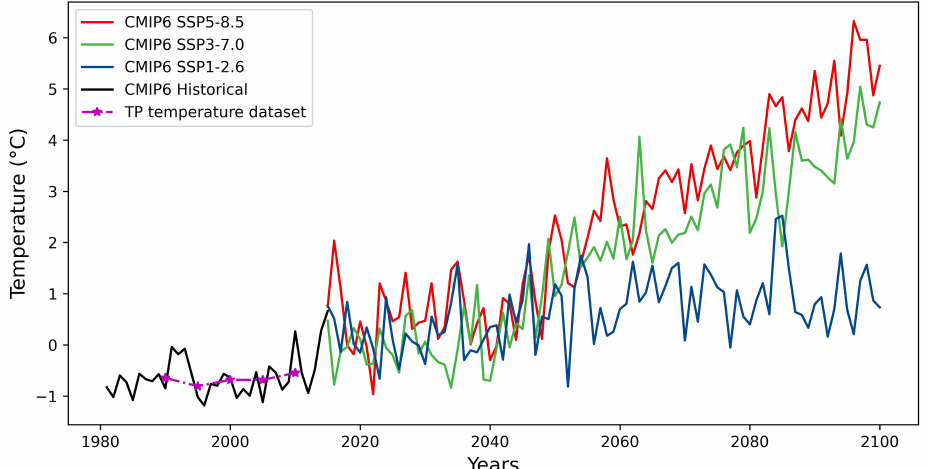
Figure 5. Time series of the mean annual surface air temperature after calibration for JMYZG under different CMIP6 climate scenarios (the magenta star points are the data obtained from the Tibetan Plateau surface air temperature dataset, which is from 1990 to 2010, with a time interval of 5 years; the black solid line represents the historical temperature of CMIP6, and the red, green, and blue solid lines represent the scenarios of SSP5-8.5, SSP3-7.0, and SSP1-2.6, respectively).